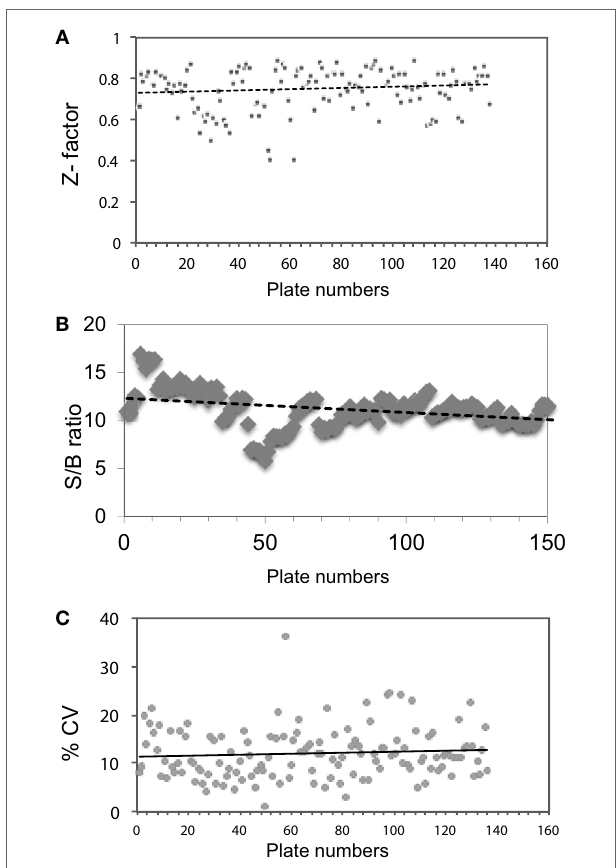
FIGURe 6 | evaluation of hts performance. (A) Z factor was calculated by taking the positive control and basal control responses of each duplicate plate and using the formula Z ′ = 1 − (3 × SD of total signal + 3 × SD of basal signal)/(total signal − basal signal) as indicated by Zhang et al. (23). (B) Signal-to-background ratio (S/B): total signal was obtained from alternating wells of columns 1 and column 22 using 17 μ M of positive control and background signal was were collected from the alternating wells of column 1 and column 22 treated with medium containing 0.1% DMSO. (C) Coefficient of variation (% CV), calculated as the SD from the wells in the basal medium divided by the wells of the positive control in all 137